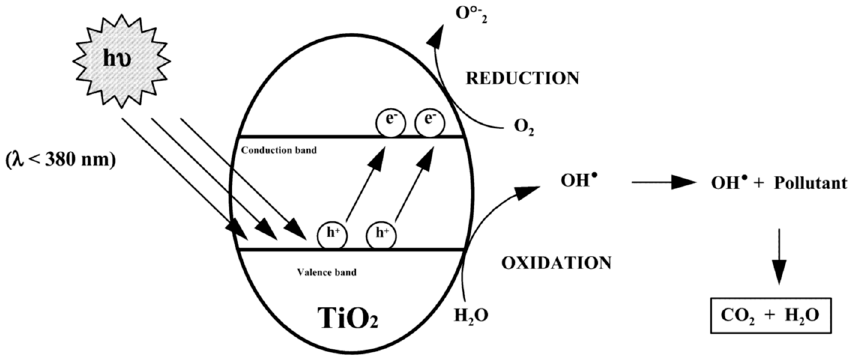
Figure 9. General mechanism of the heterogeneous photocatalysis [8].